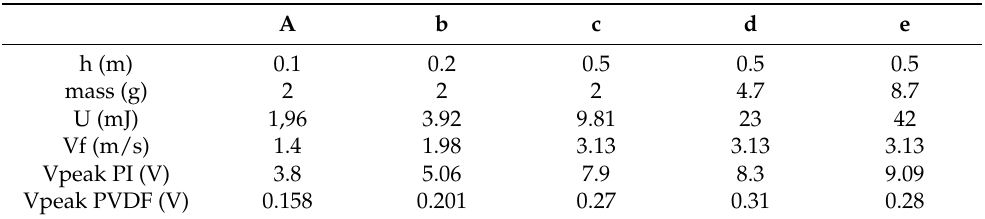
Table 2. Peak voltages recorded with PI.876.SP1 and PVDF the sensors with varying test mass m and free-fall height h.